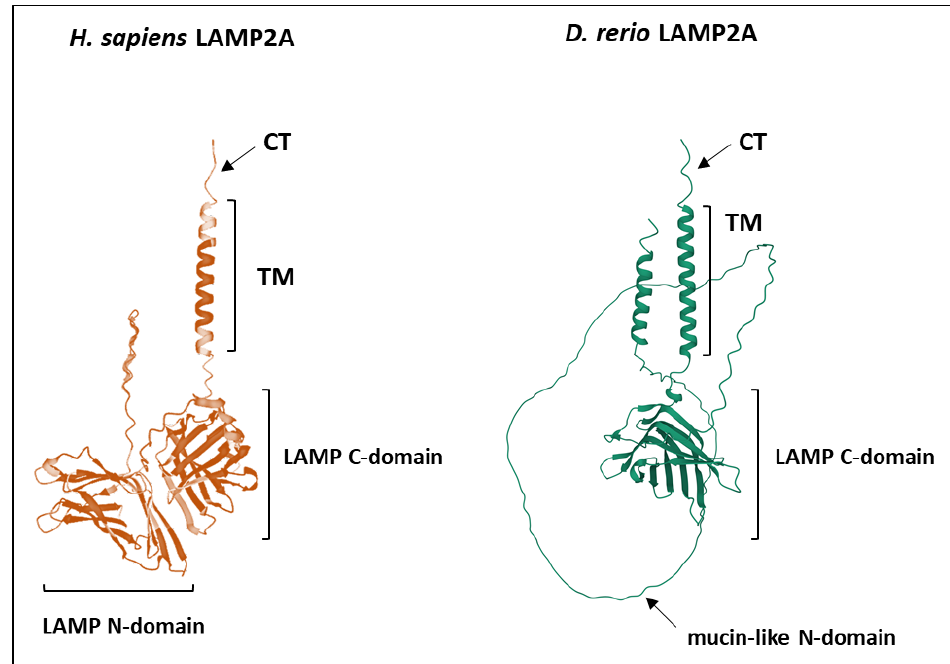
Figure 7. Structure prediction of Homo sapiens and Danio rerio LAMP2As showing the strong structural divergence of the two proteins at the membrane-distal LAMP domain (Source: AlphaFold Protein Structure Database [73,74]). Instead of a beta-sheet structure classically observed in most vertebrates, the zebrafish N-domain exhibits a mucin-like structure. CT, cytoplasmic tail; TM, transmembrane domain; LAMP C-domain, membrane-proximal LAMP domain; LAMP N-domain, membrane-distal LAMP domain.